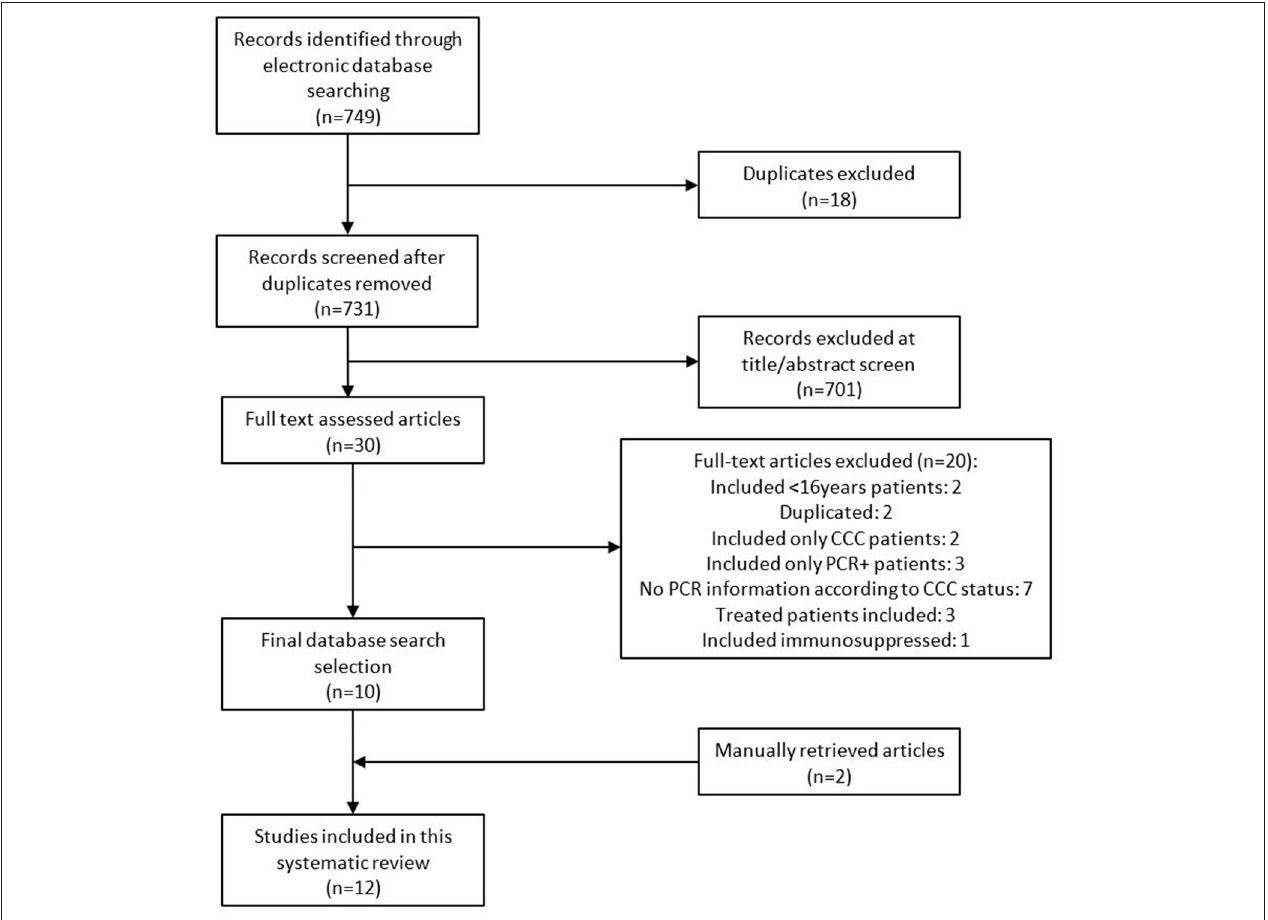
FIGURE 1 | The Preferred Reporting Items for Systematic Reviews and Meta-Analyses (PRISMA) flow diagram of included articles. CCC, chronic chagasic cardiomyopathy; PCR, polymerase chain reaction.